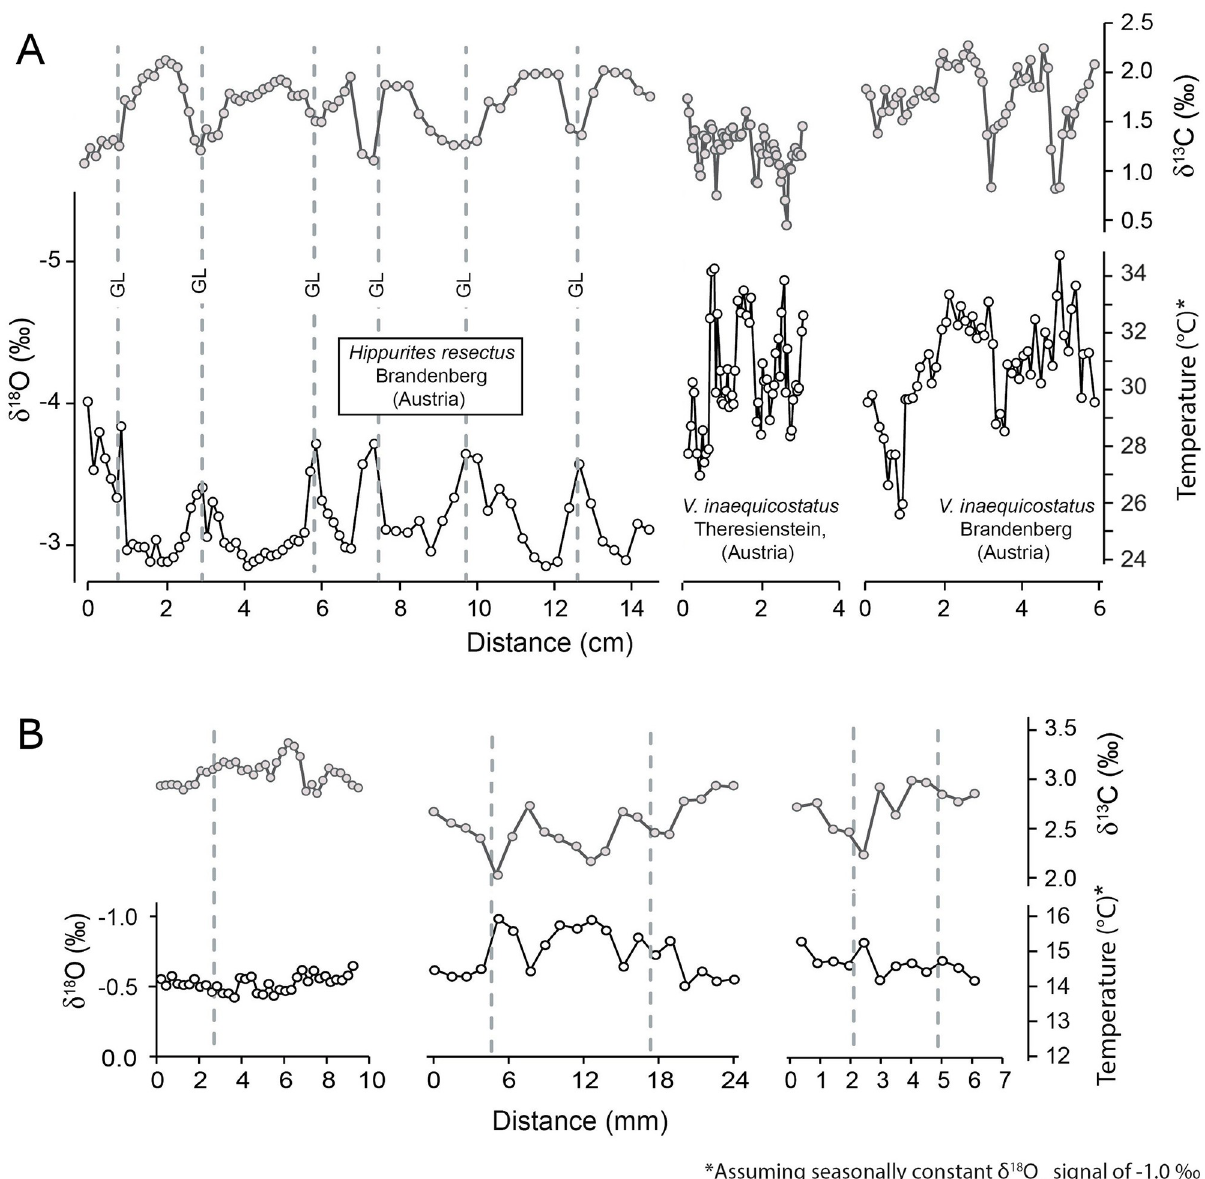
Fig 4. Sequentially sampled δ 13 C and δ 18 O values the studied rudist and inoceramid shells and temperatures reconstructed thereof. (A) In the Hippurites resectus , the position of the growth lines (GL; gray dotted lines) coincided with the δ 18 O minima, which suggest that shell growth occurred mostly during winter. In comparison, the shape of the δ 18 O curves of the coeval Vaccinites inaequicostatus [65] suggest a predominant summer shell growth. (B) In the Inoceramus sp. specimens, growth lines were located shortly before the seasonal δ 18 O minima, suggesting that the full seasonal temperature amplitude was recorded by the bivalves. Temperatures were computed assuming an average ocean δ 18 O water value of -1.00 ‰